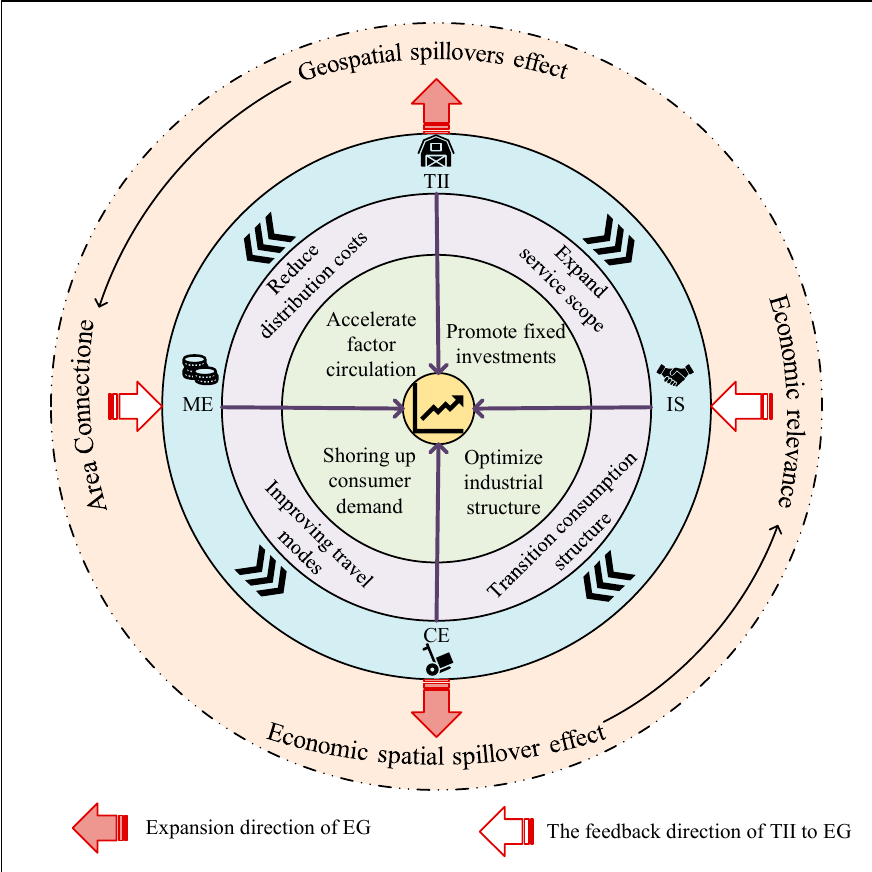
Figure 2. Mechanism of actions of TII on EG. From the interregional perspective, the economic development level, transport infra- structure level, IS, labor input, and opening-up level of different countries show spatial heterogeneity and they function together to produce different economic agglomeration effects [54]. As a result, the spatial spillover effect of TII exhibits different action directions and outcomes.